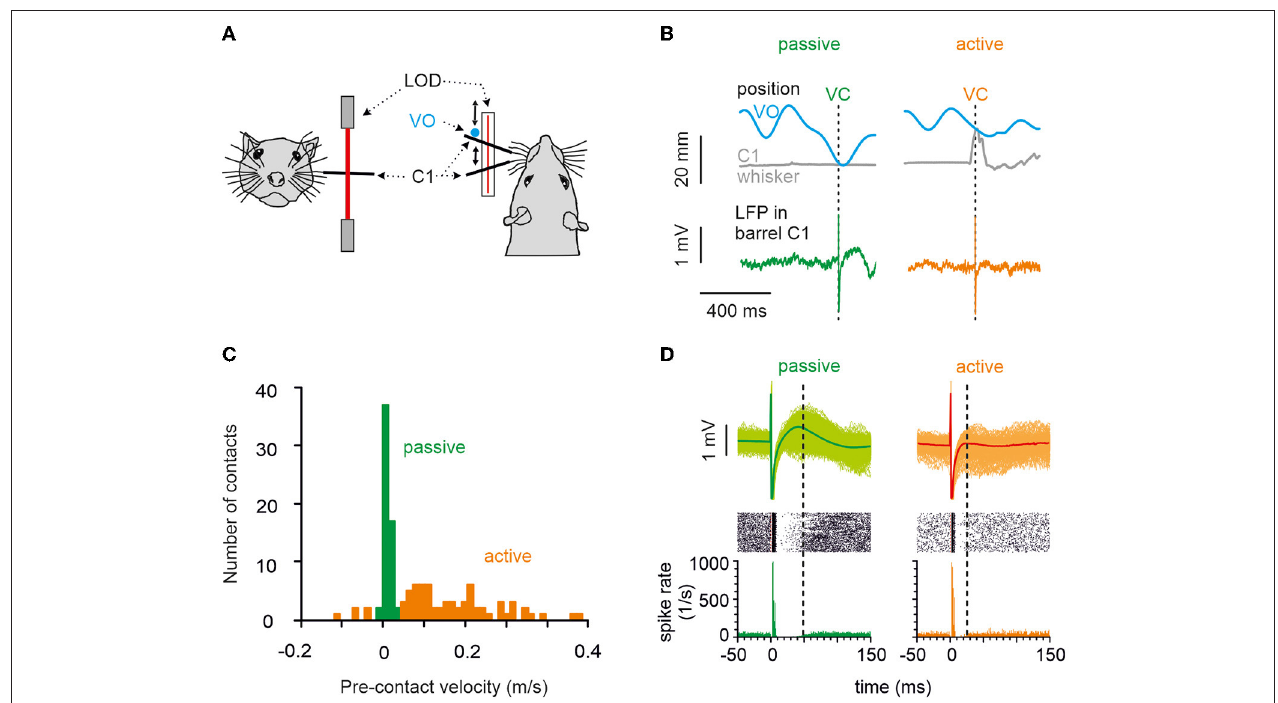
FIGURE 1 | Behavior, the principal measurements, and classification of touches into active vs. passive. (A) A head-fixed rat’s whisker C1 was equipped with a light polyimide tube and tracked in real-time using a laser optical device. The movement of a virtual object (VO) was modeled in a computer and compared in real-time to the whisker position. (B) When measured whisker trajectory and modeled VO movement trajectory crossed, a VC occurred (realized as microstimulation in barrel column C1). Two VCs (arrows), one passive (left) and one active (right), are shown. Gray: the trajectory of whisker C1. Blue: the trajectory of the VO. Bottom: examples of LFP responses in barrel cortex with passive (green) and active (orange) VO contacts. (C) Histogram of whisker mean velocity distribution, measured within the 10ms interval preceding the VCs obtained from an example session. Precontact velocities, classified as passive and active, are marked in green and orange, respectively. (D) Circumstantial observation of spikes (obtained in one animal in one session) allows a glimpse of how features in LFP signals relate to those in cortical spikes rates. Bottom: Spike density of spike responses to passive (green) and active (orange) contacts. Note that the inhibitory period was longer and more pronounced after passive contacts, while excitation remained unaffected (marked by the vertical broken line on the right of each plot). Center: Raster display. Top: Overlay of cutouts of the LFP responses to passive (green traces) and active (orange traces) contacts recorded from the same electrode as the spikes shown below. The thick trace is the average evoked LFP. The slow positive deflection amplitude reflects the strength and duration of the inhibitory response as seen in the spike density. Time of virtual contact is at time